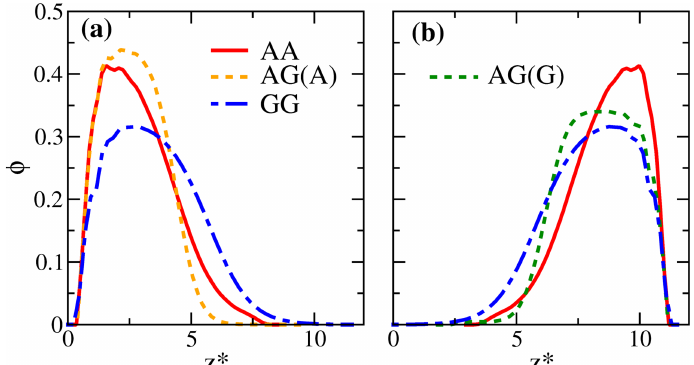
Figure 5. Local volume fraction distributions of the polymer beads ( φ ) plotted along the scaled z ∗ = z / R 0 g position for systems AA, AG, and GG. The distributions of the bottom brush are shown in ( a ); those for the upper brush are shown in ( b ). The dashed curves in ( a , b ) correspond to the profiles of brush A and brush G in the binary system, respectively. For clarity and easy comparison, the brush profiles in ( b ) are shifted horizontally to make all curves start from the same z ∗